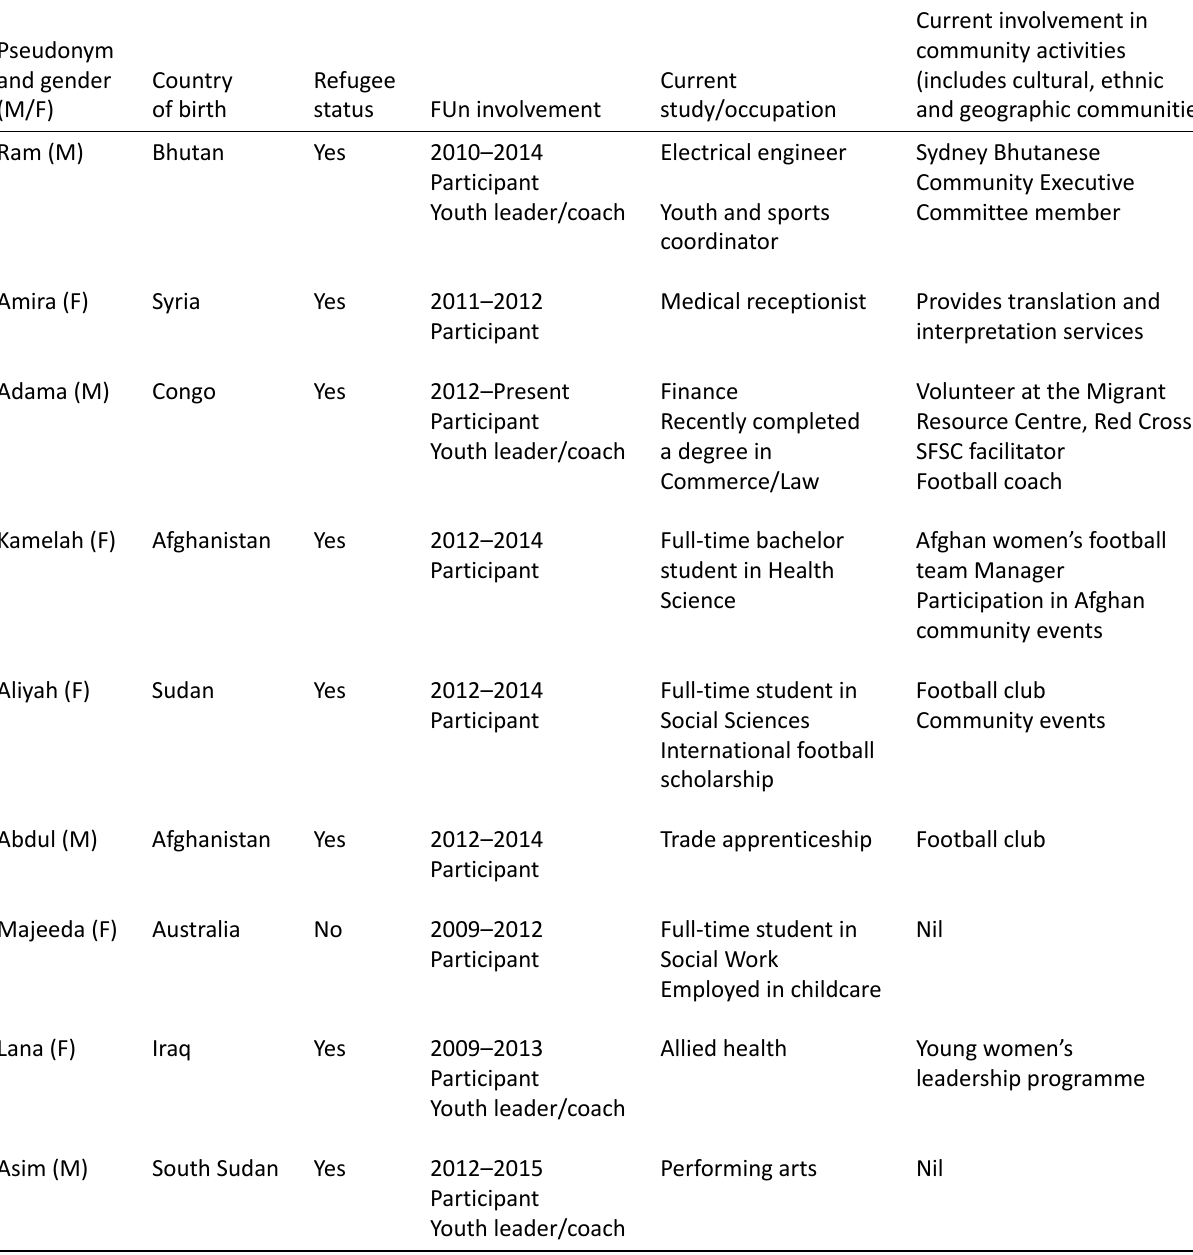
Table 1. (Cont.) Participant characteristics and